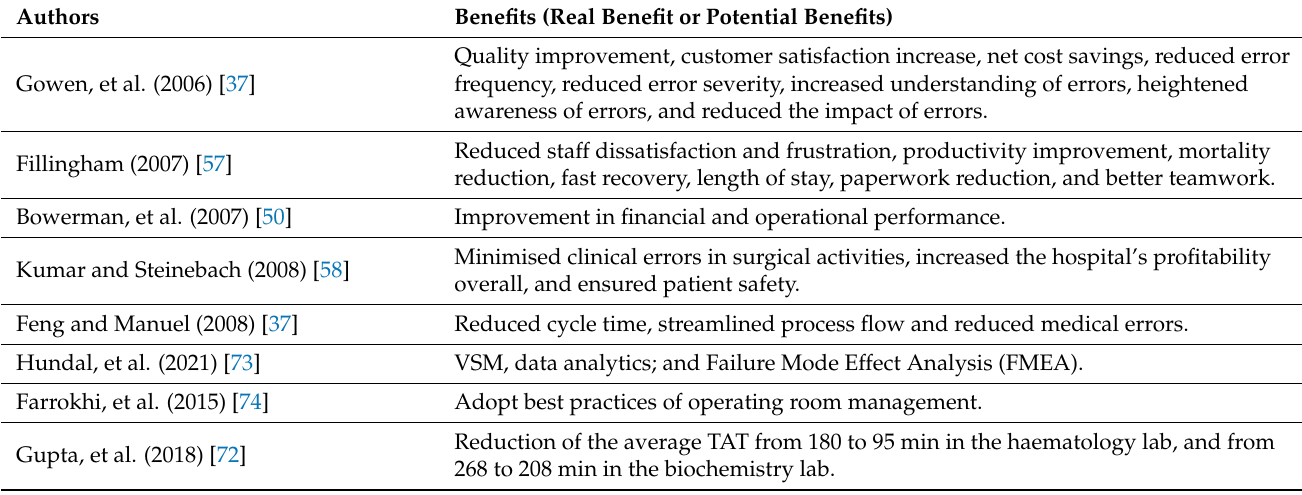
Table 2. Benefits of LSS in